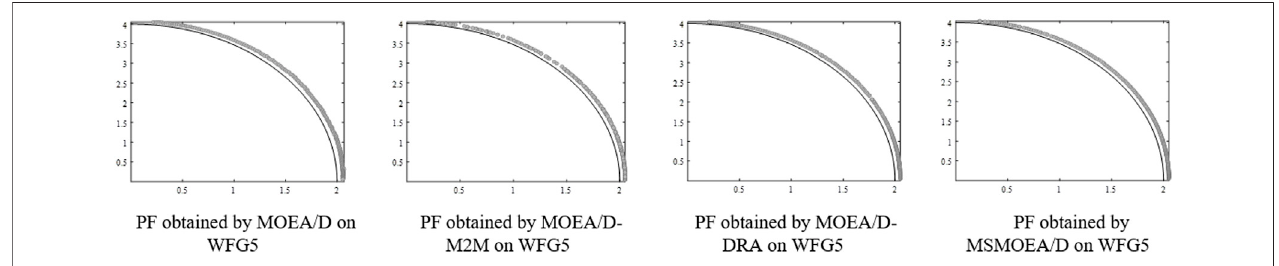
FIGURE 12 | PF obtained by MSMOEA/D and MOEAs on two-objective WFG5.